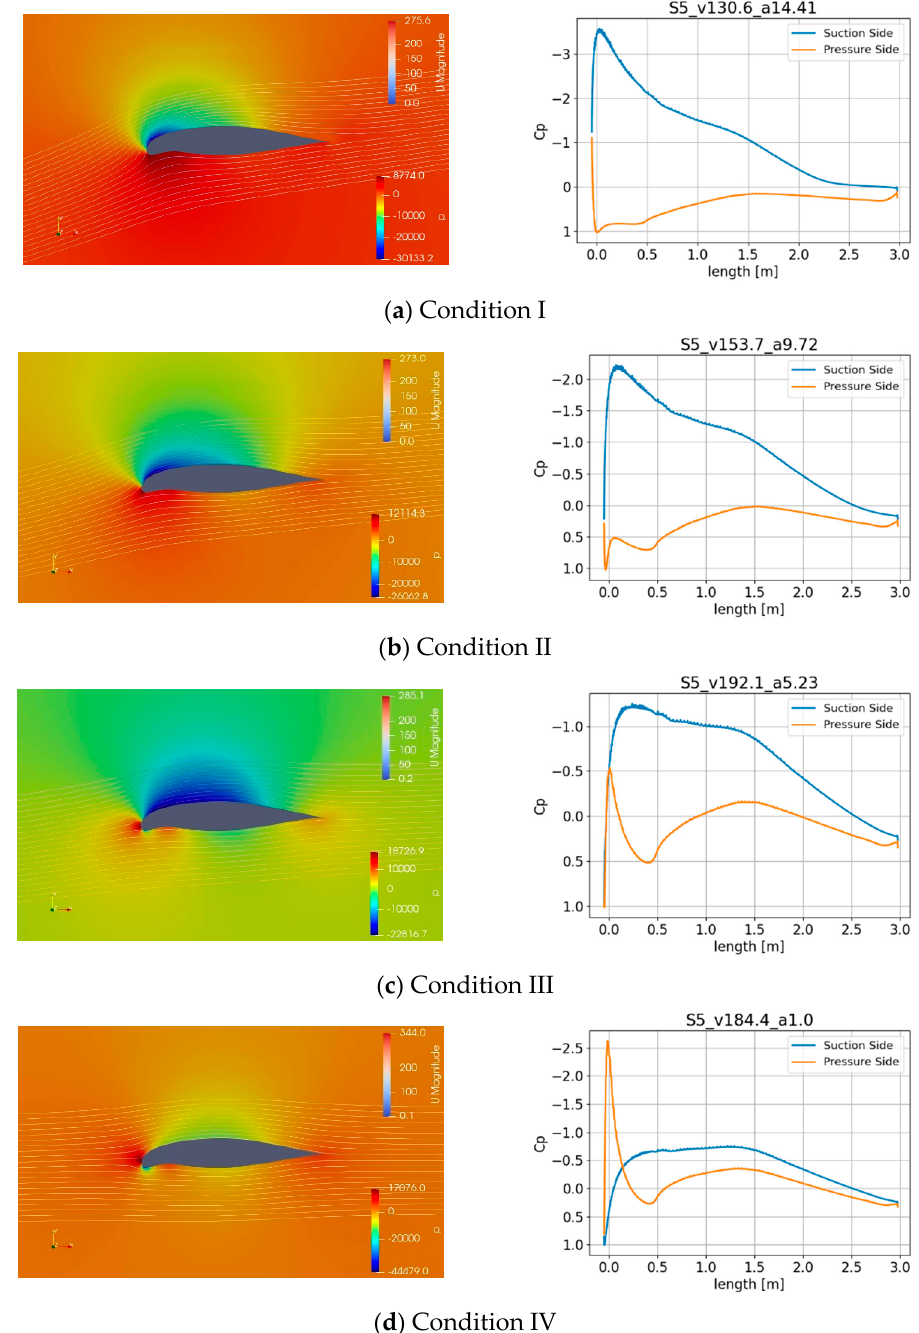
Figure 5. Pressure and flow ( left ) and c p distribution ( right ) for cruise profile S5 in four extreme conditions.